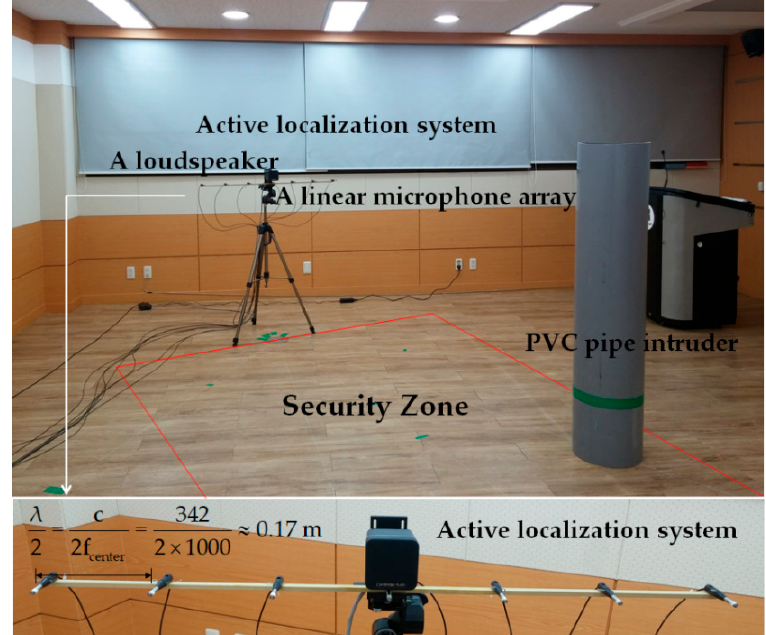
Figure 13. Experimental configuration to estimate the position of a PVC pipe using an active localization system in a classroom. This experiment was performed in an empty classroom to minimize the influence of the presence of furniture or other interior materials in the room. Table 3. Results of room acoustic parameters measured in the control space as in Figure 13 at positions shown in Figure 10a.